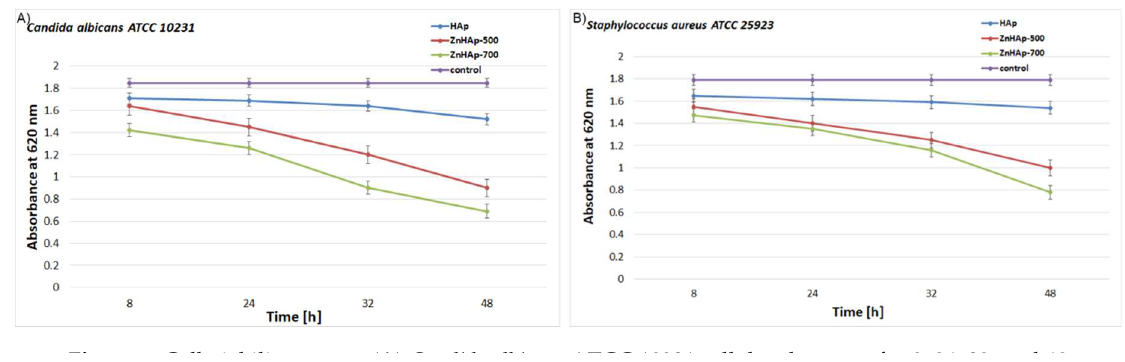
Figure 9. Cell viability assays: ( A ) Candida albicans ATCC 10231 cell development for 8, 24, 32, and 48 h in the presence of HAp and ZnHAp layers; ( B ) Staphylococcus aureus ATCC 25923 cell development for 8, 24, 32, and 48 h in the presence of ZnHAp composite layers.